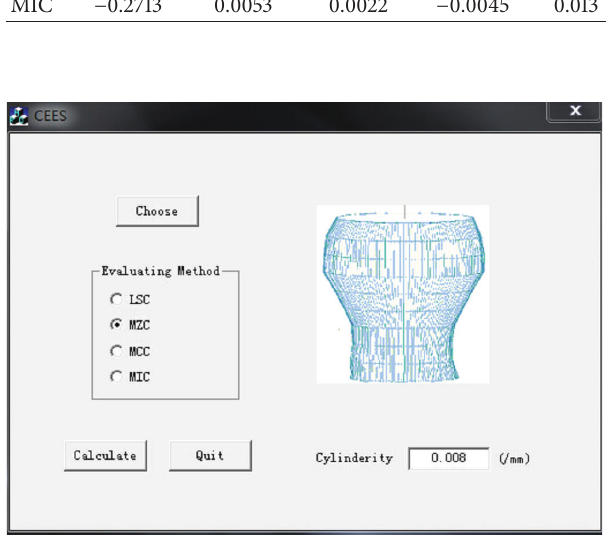
Figure 11: The error evaluating